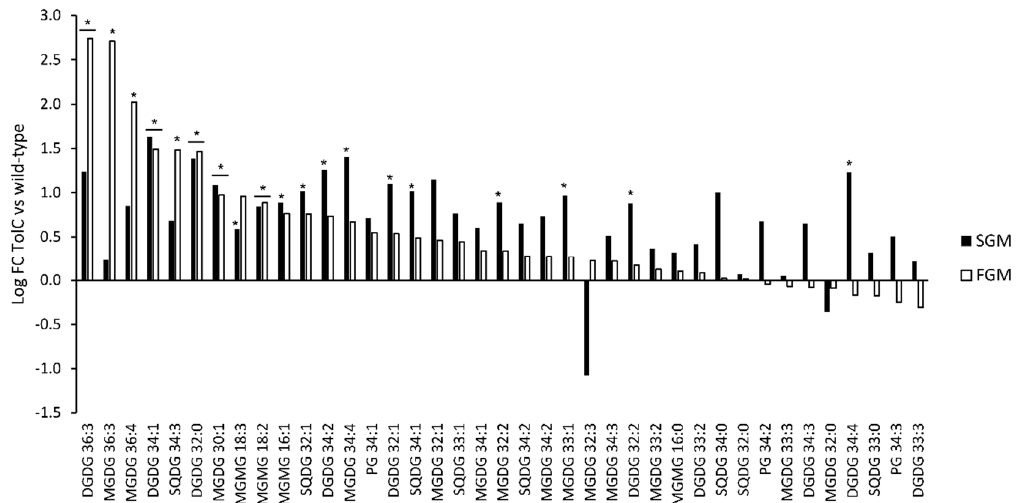
Figure 9. Comparison of abundance of selected lipid species detected in cells of Synechocystis sp. PCC 60803 wild-type and tolC -mutant (TolC) strains cultivated in FGM (white bars) and in SGM (black bars). Fold-changes were calculated by dividing the average peak area of a given lipid species detected in samples collected from the mutant strain in a given cultivation setup ( n = 6) by the average peak area of the same lipid species detected in samples obtained from the wild-type in the same cultivation condition ( n = 6). The log 2 fold-change values are presented: positive values correspond to higher peak area in the tolC -mutant in comparison to wild-type, while negative values represent peak areas higher in wild-type strain in comparison to the tolC -mutant strain. Mann-Whitney unpaired analysis, * p < 0.05, bars with no asterisks—no statistically significant difference.